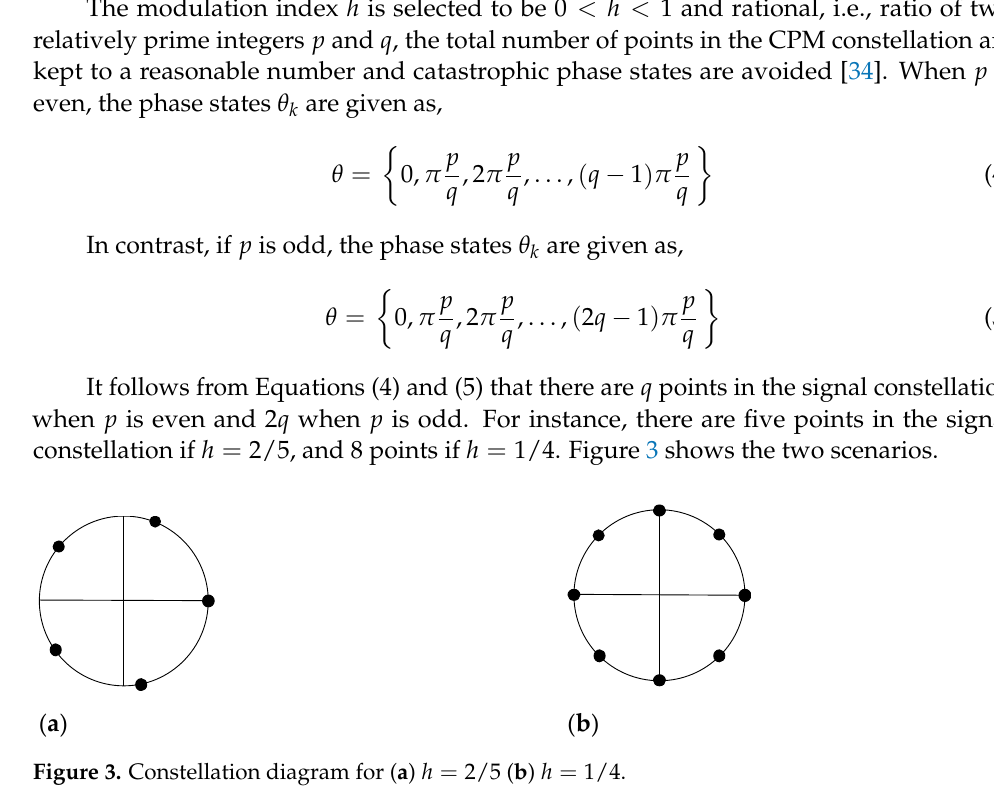
Figure 2. Trellis diagram for h = 1/2.